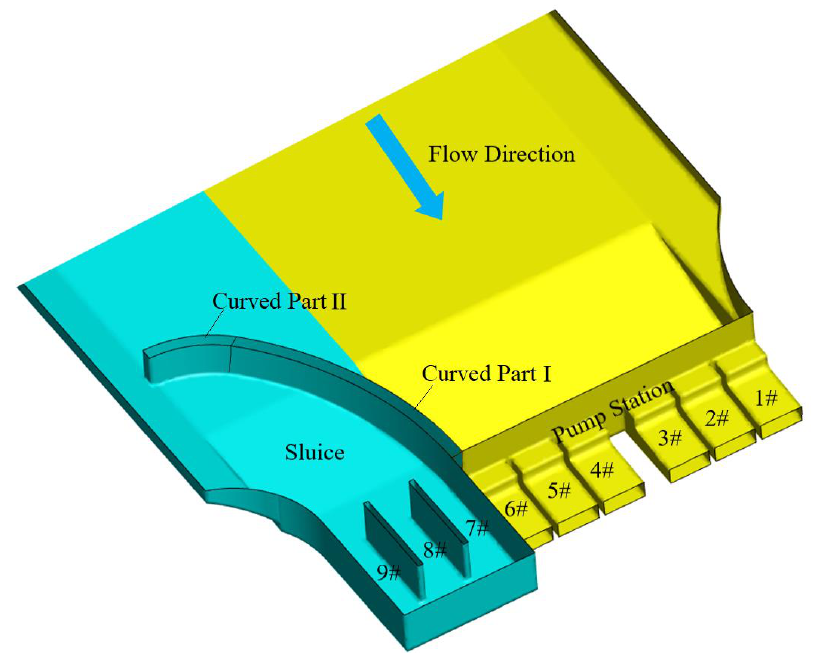
Figure 4. 3D layout of the training wall (operational state of pumping).